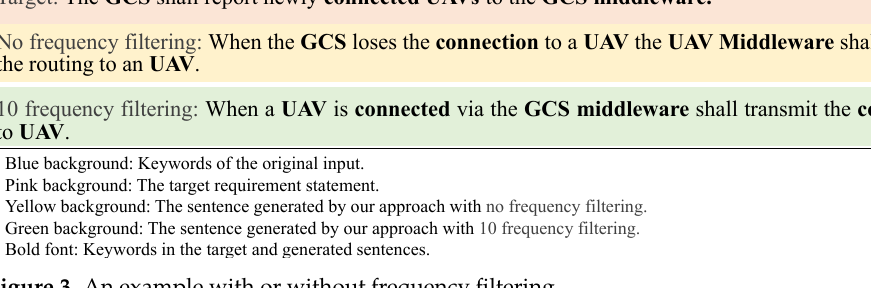
Figure 3. An example with or without frequency